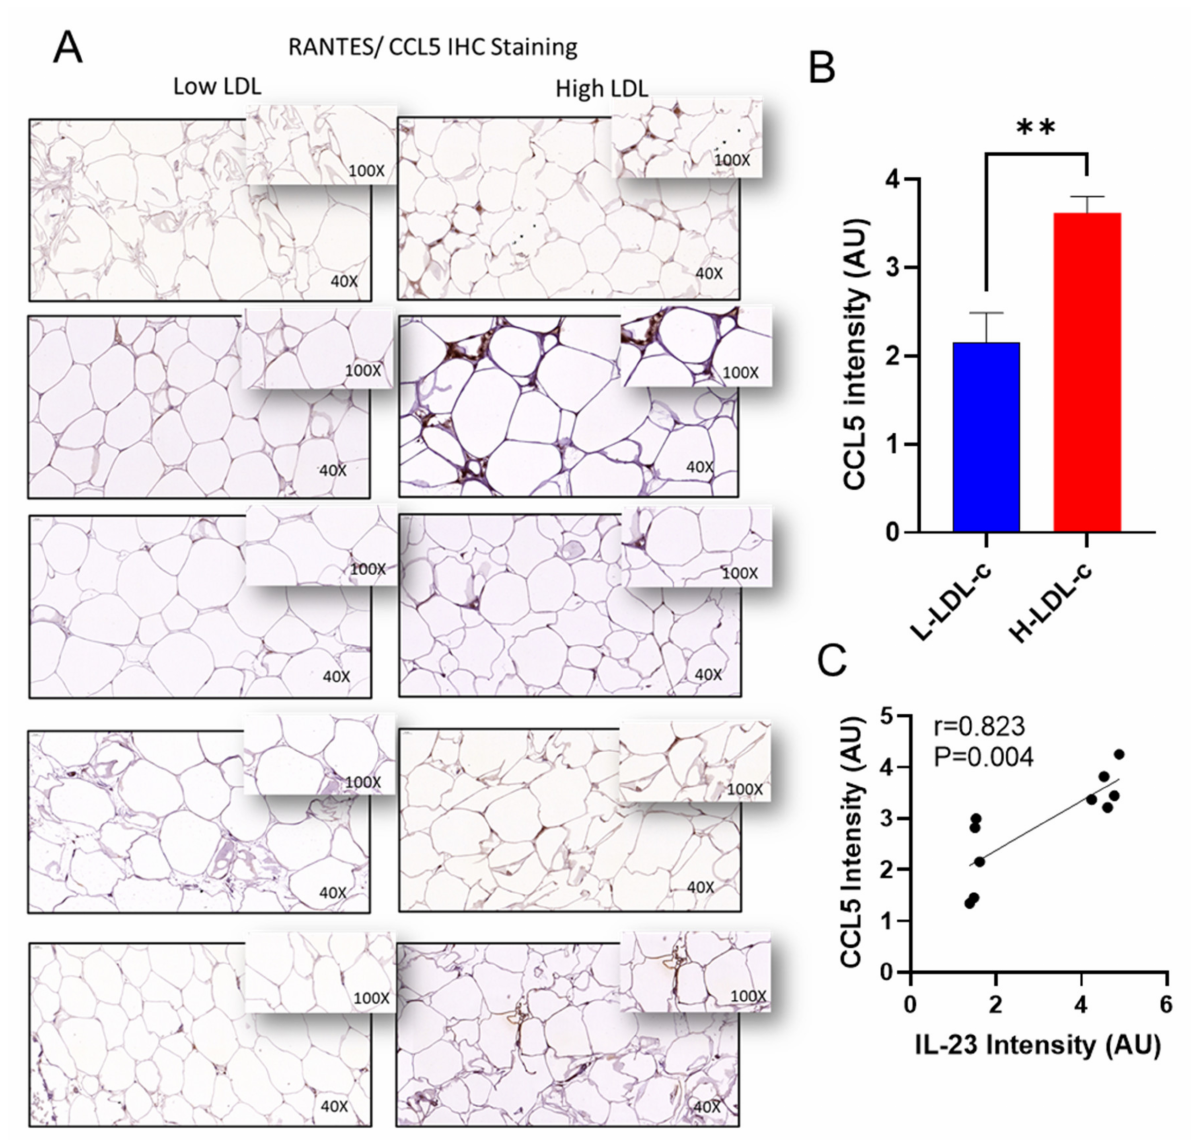
Figure 4. Increased adipose CCL5 protein expression in people with high LDL-c and positively correlated with IL-23 protein. CCL5 protein expression was determined in people with low LDL-c (L-LDL-c) and high LDL-c (H-LDL-c), five each, using IHC. ( A ) The representative IHC images obtained from three independent determinations with similar results show the increased adipose tissue TNF- α expression (40 × or inset × 100 magnification) in people with H-LDL-c ( ≥ 2.9 mmol/L) compared to those with L-LDL-c (<2.9 mmol/L). ( B ) Increased CCL5 protein expression is shown in the H-LDL-c group compared to the L-LDL-c group ( p = 0.0053). Staining intensity shown as arbitrary units (AU). ( C ) IL-23 protein correlated with CCL5 protein in adipose tissue. p -values < 0.05 were considered as statistically significant. ** Highly